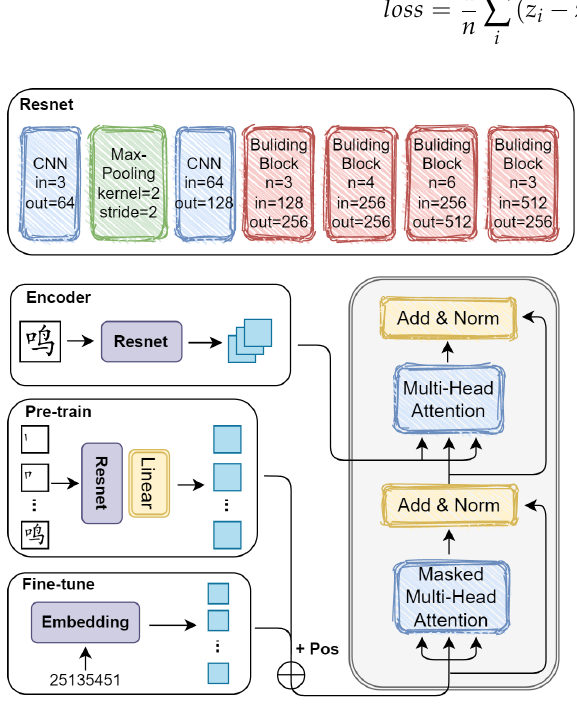
Figure 6. The detailed architecture of encoder and